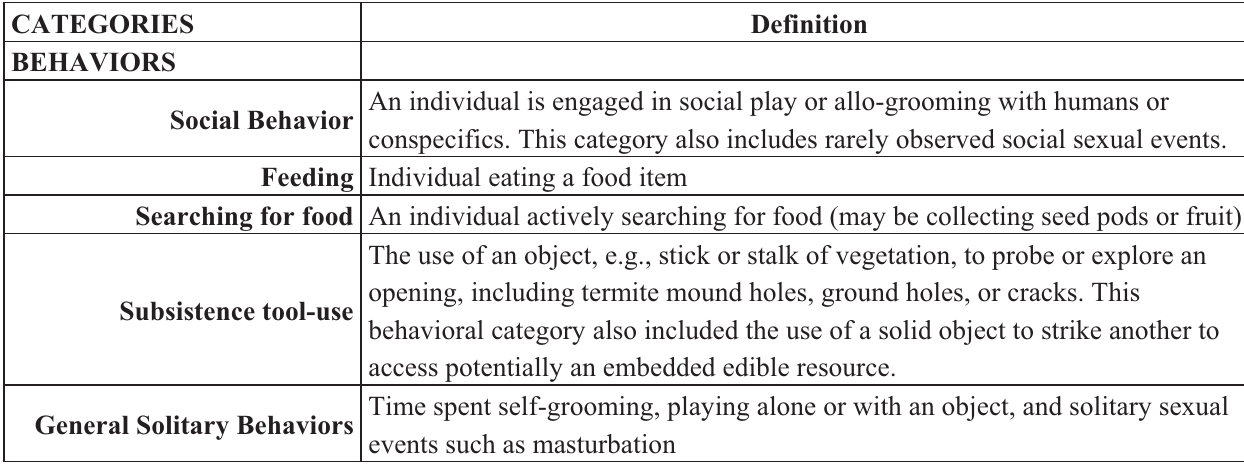
Table 3. Ethogram for data collection categories. All categories were recorded during focal follows, including behavior, location and human